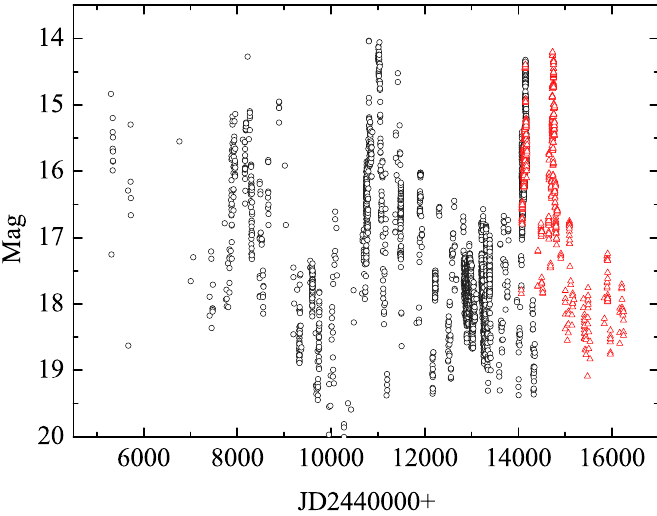
Figure 1. Historic light curve of AO 0235+164 during JD 2445300 to JD 2456247. The open circles are from the literature and the triangles are from our own